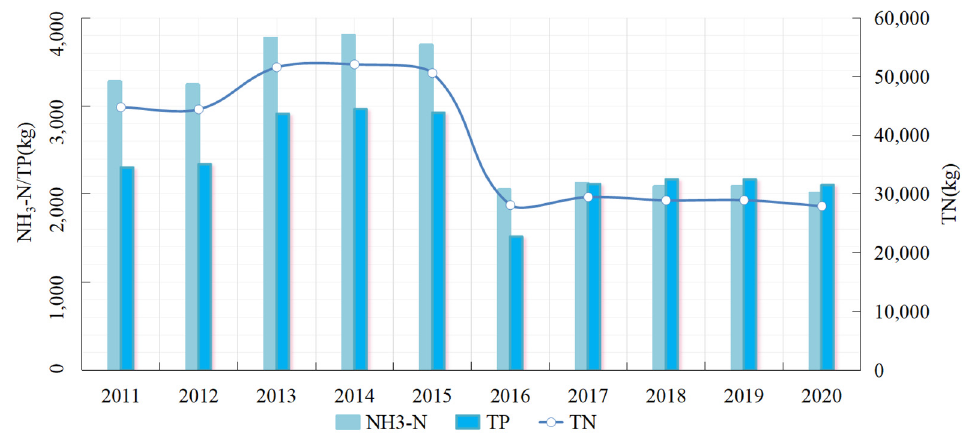
Figure 6. Changes in pollutant discharge loss from crop planting in Ganzhou district from 2011 to 2020.